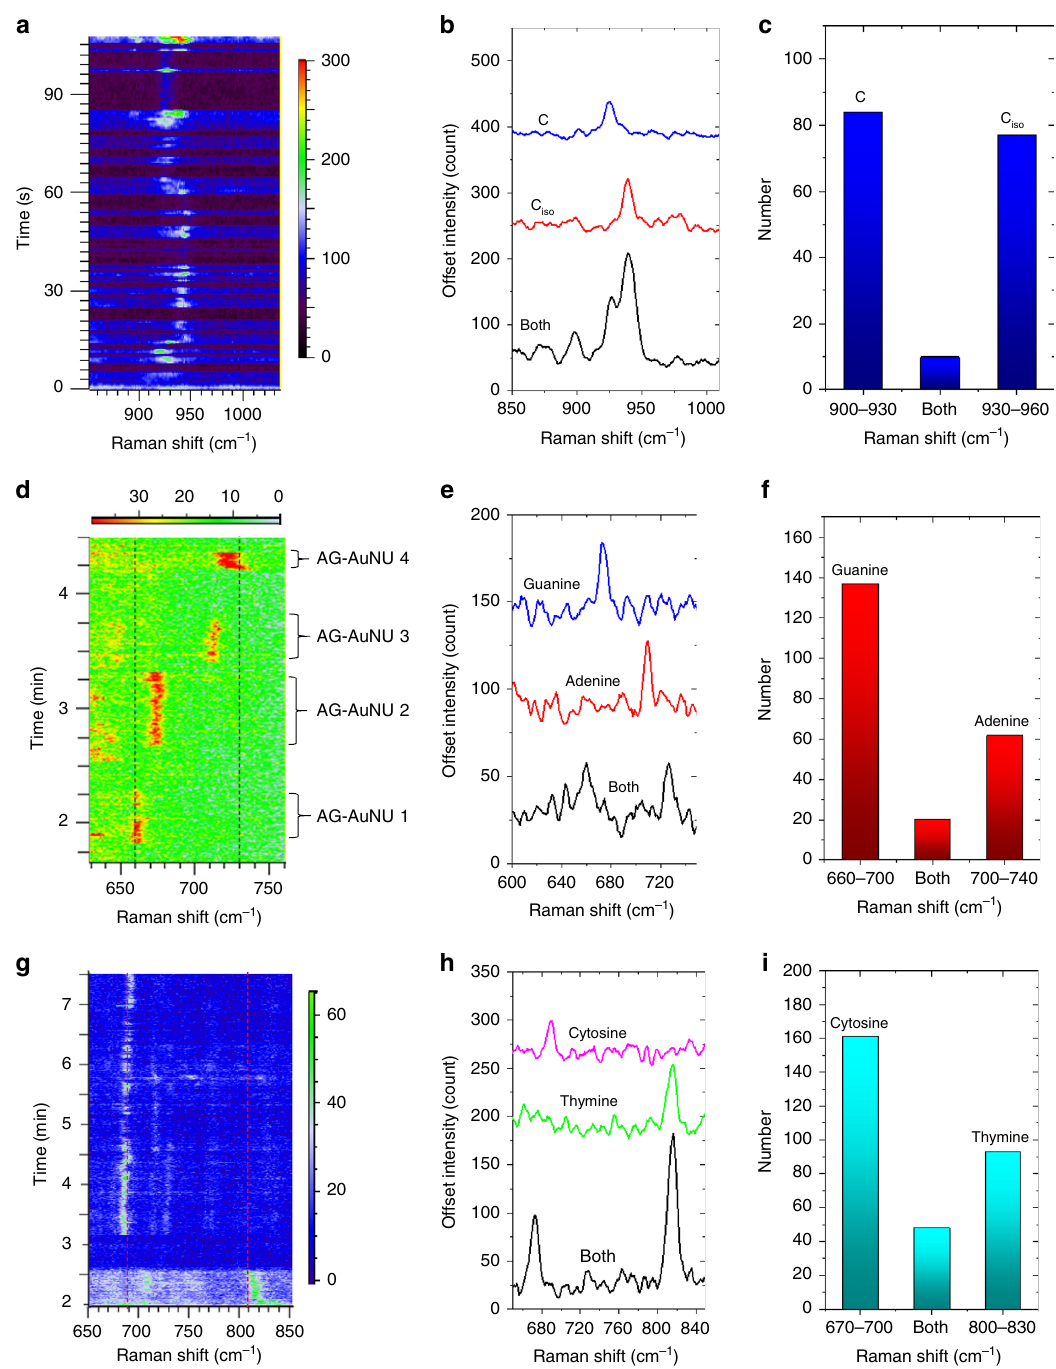
Fig. 4 BiASERS analysis of single-molecule SERS of individual nucleobases. a SERS time series of the gold nanourchins with submonolayers of equal moles of cytosine (C) and isotope-edited cytosine (C iso ) molecules adsorbed on their surface (C iso C – AuNUs) trapped in gold nanoholes. b Representative single- molecule spectra (colored curves) and multi-molecule spectrum (black curve) of C iso C – AuNU, respectively. c BiASERS distribution of C iso and C out of about 1030 spectra. d SERS time series of the gold nanourchins with submonolayers of equal moles of adenine (A) and guanine (G) molecules adsorbed on their surface (AG – AuNUs) trapped in a nanohole. e Typical SERS spectra of single-molecule spectra (colored curves) and multi-molecule spectrum (black curve) of AG – AuNU. f BiASERS distribution of A and G out of about 1200 spectra. g SERS time series of the gold nanourchins with submonolayers of equal moles of C and thymine (T) molecules adsorbed on their surface (CT – AuNUs) trapped in a nanohole. h Typical SERS spectra of single-molecule spectra (colored curves) and multi-molecule spectrum (black curve) of CT – AuNU. i BiASERS distribution of C and T from about 1500 collected spectra. All color bars represent the signal-to-baseline intensity of the SERS peaks. The dotted lines indicate SERS peak positions of multilayer nucleobases (black for A or G, red for C or T) adsorbed on silver nanoparticles without bias, respectively, as reported in ref. 31